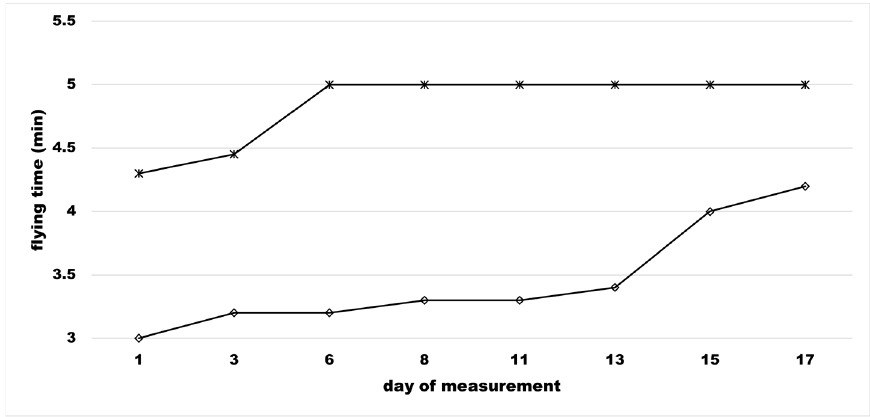
Figure 2. Peregrine × Lanner falcon’s flight time. Median value of the raptor’s flying time (min) during the resistance micro-cycle. At the top ( ∗ ), the value of flying time at ground level, at the bottom ( ◊ ) flying time at high altitude.